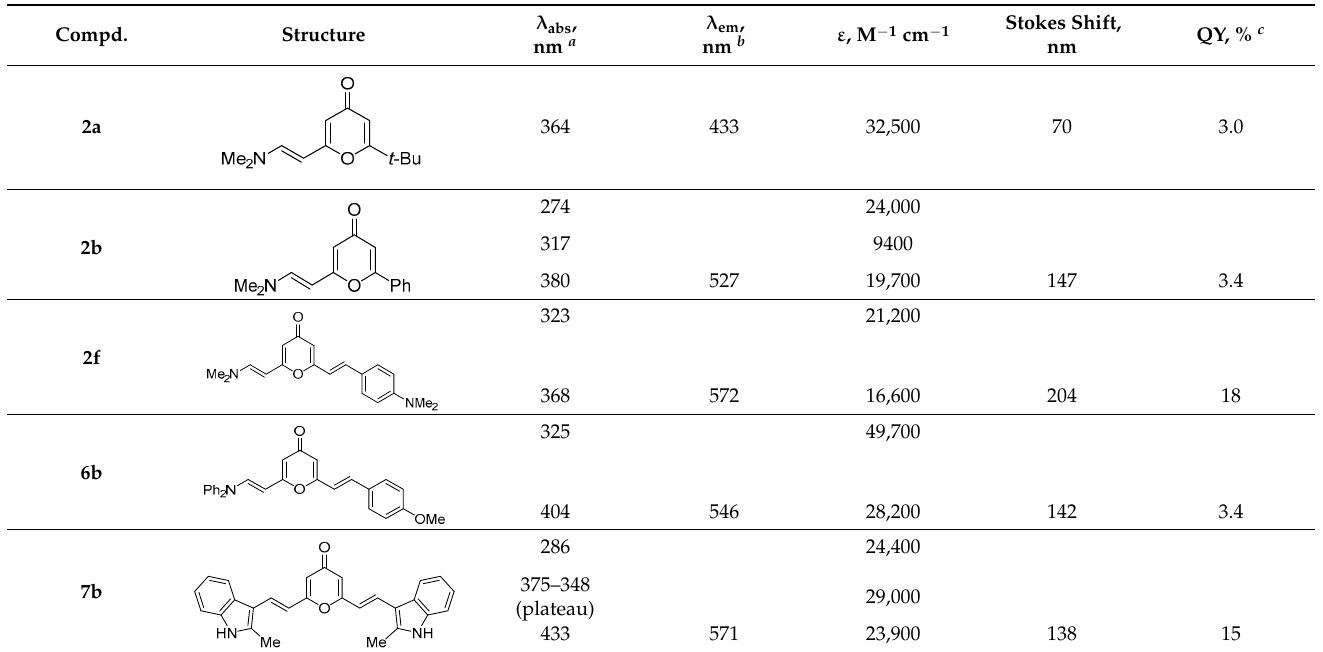
Table 5. Absorption and fluorescence spectral data of compounds 2a,b,f; 6b; and 7b in MeOH (C = 1.0 × 10 − 5 M). Compd.